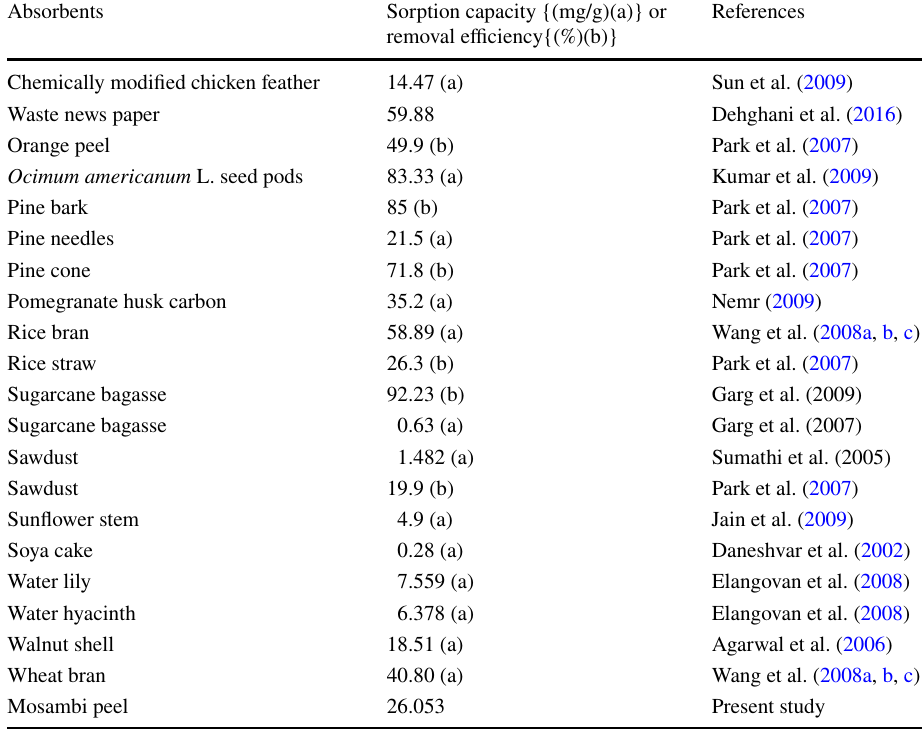
Table 5 Comparison of mosambi peel dust with other reported adsorbents